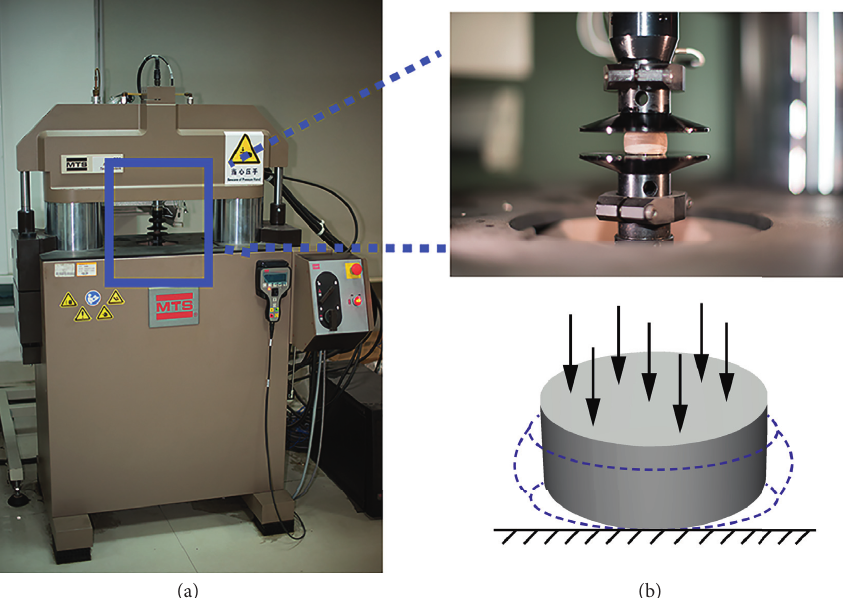
Figure 1: Testing setup and samples. (a) MTS test system; (b) cylindrical sample under